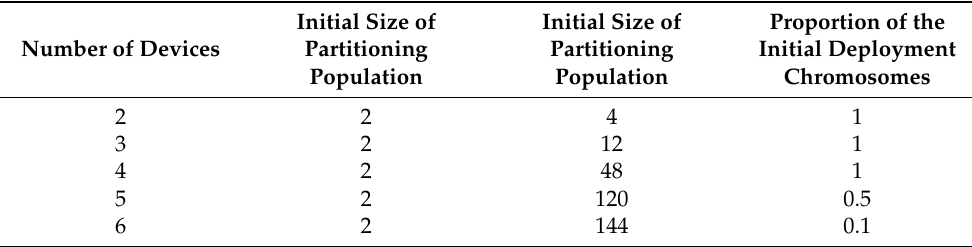
Table 2. The initial partitioning and deployment chromosome population size in experiments on B-AlexNet.